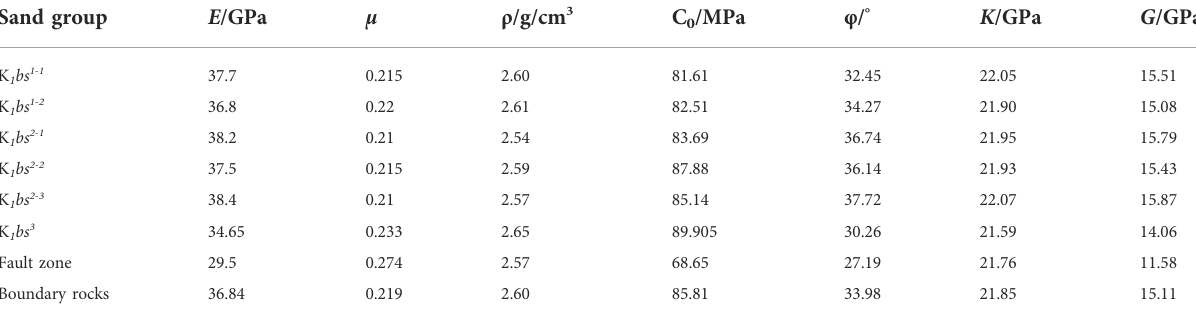
TABLE1AveragemechanicalpropertiesoftheK 1 bs tightsandstonesfromtriaxialcompressionaltests.Inthetable, E istherockYoung ’ smodulus; μ is the Poisson ’ s ratio; σ c is the rock compressive strength; ρ is the rock density; φ is the rock internal friction angle; C 0 is the rock cohesion, K is the rock bulk modulus, and G is the rock shear modulus.